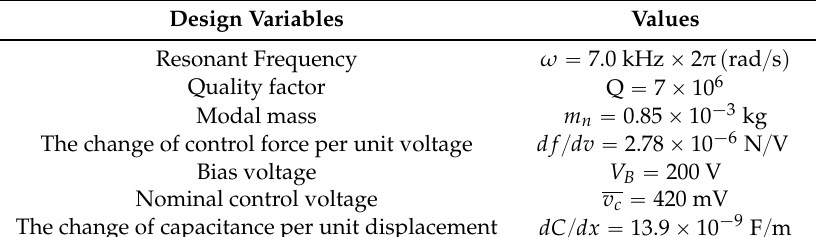
Table 1. The design variables for the full time equation of motion.